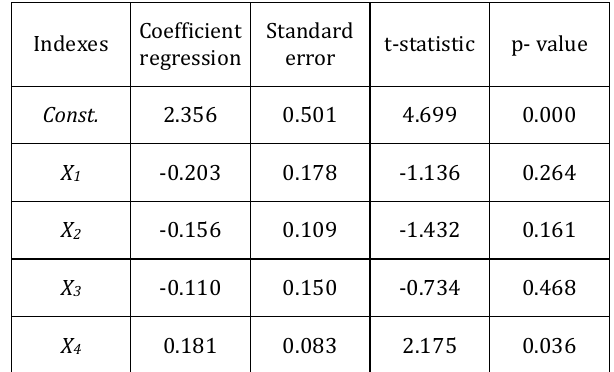
Table 1. Results of multiple regression linear modeling of the impact of gender, age, education and social status on willingness of consumers to pay a price premium for ecological goods (Source: author`s